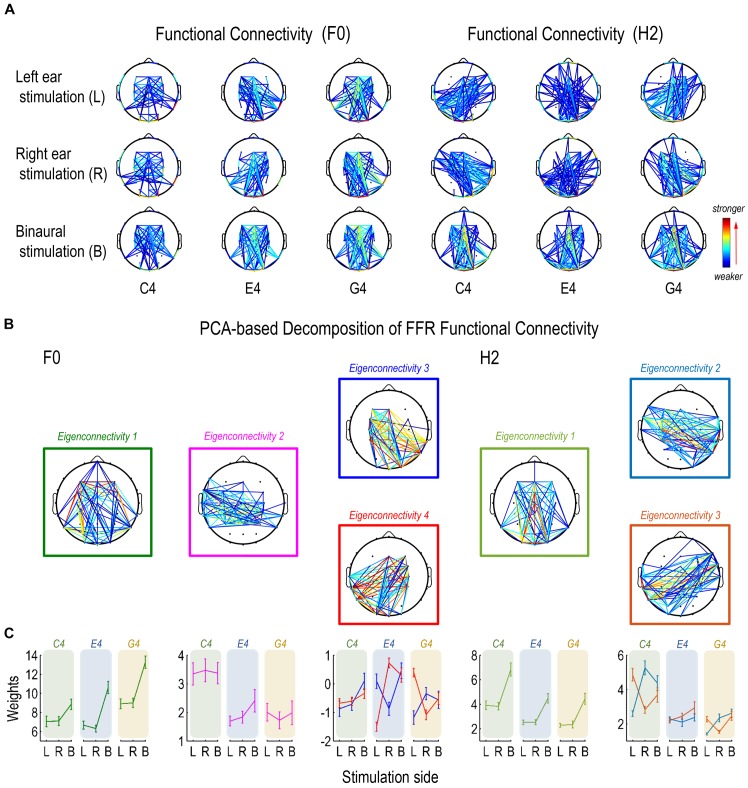
Functional connectivity pattern of FFR. (A) Functional connectivity refers to the inter-trial coherence of phase difference between each pair of channels. Functional connectivity patterns of the FFR vary with stimulus F0 for both F0 and H2 components. (B) Decomposition of connectivity patterns for the F0 component results in four principal components (eigenconnectivities, ECs), one representing a symmetrical network (EC1), one representing a slightly left lateralized network that is more activated for FFRs to C4 (EC2), and two representing a pair of mirror-distributed lateralized networks (EC3/4). Decomposition of connectivity patterns for the H2 component results in three ECs, one representing a symmetrical network similar as for the F0 component (EC1) and two representing a pair of mirror-distributed networks (EC2/3). (C) As to the F0 component, the two lateralized networks (EC3/4) are similarly activated for FFRs to C4; the network lateralized to the contralateral side of stimulation is more activated for FFRs to E4, and the network lateralized to the ipsilateral side is more activated for FFRs to G4. As to the H2 component, the pair of mirror distributed networks (EC2/3) are activated in a similar way across stimulation sides for FFRs to C4 and G4, but not for FFRs to E4. Error bars refer to ±SEM. For display, only 15% pairs of electrodes with the closest connections are displayed in each network.